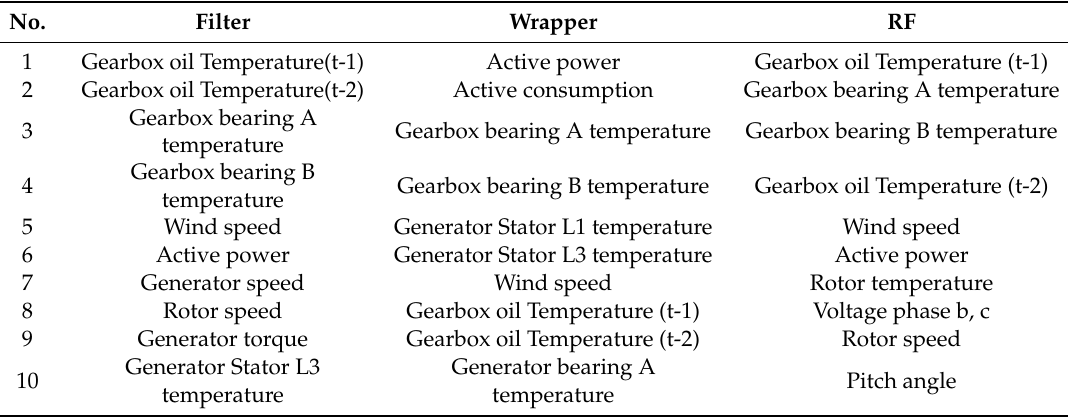
Table 3. Result of the three feature selection